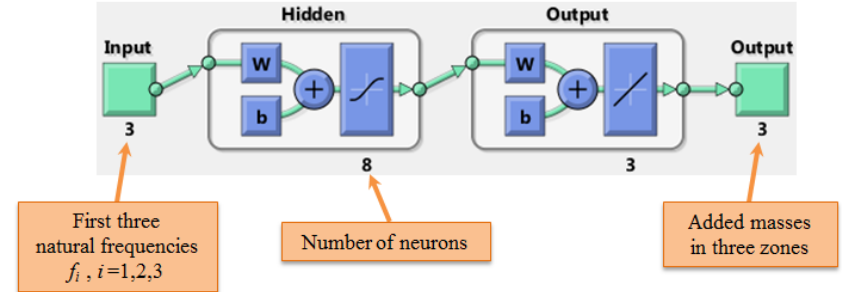
Figure 9. Neural network model created in MATLAB with the parameters n i / p = 3, n neu = 8 and n o / p =